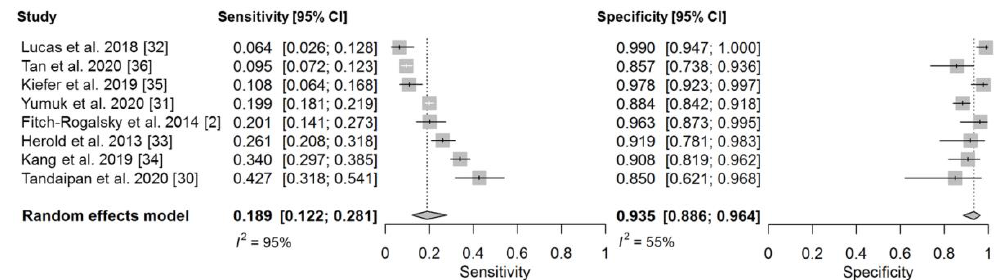
Figure 4. Paired forest plot for the sensitivity and specificity of anti-DFS70 antibodies in patients with a positive ANA test result.